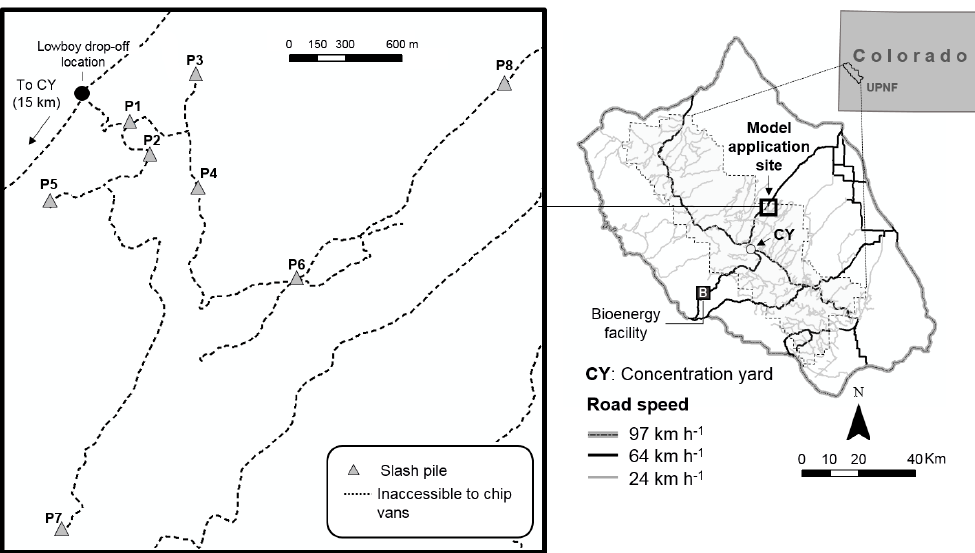
Figure 5. Spatial locations of forest residue piles, lowboy drop-off, and potential concentration yard location for a small area of Uncompahgre National Forest (UNF), Colorado. A bioenergy facility is assumed to be located approximately 36 km southwest from the concentration yard at a coal-fired power plant. Table 2. Residue volumes in bone dry tons (bdt) at each pile location and distances to lowboy drop-off